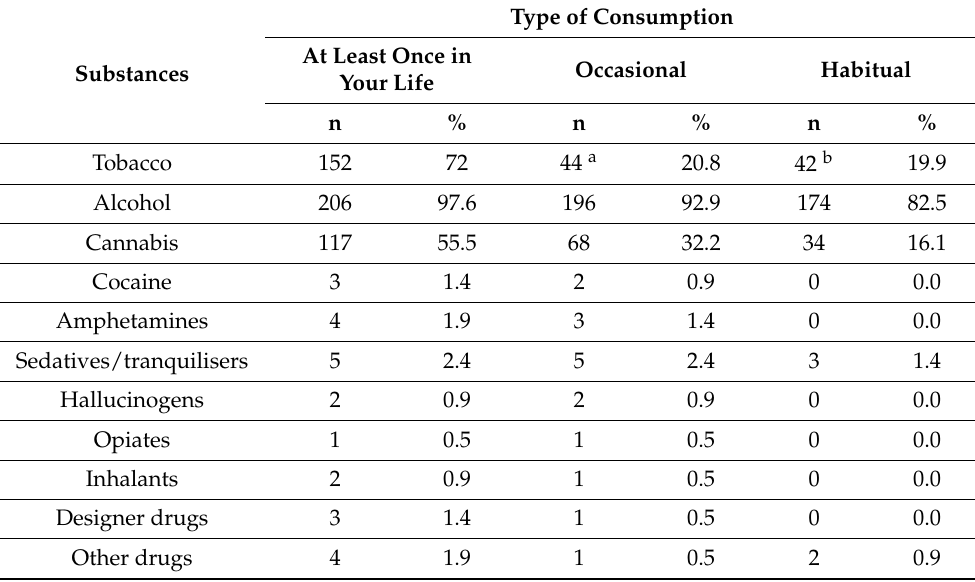
Table 2. Consumption of addictive substances. University students in Castilla y Le ó n, academic year 2019/2020 (N =